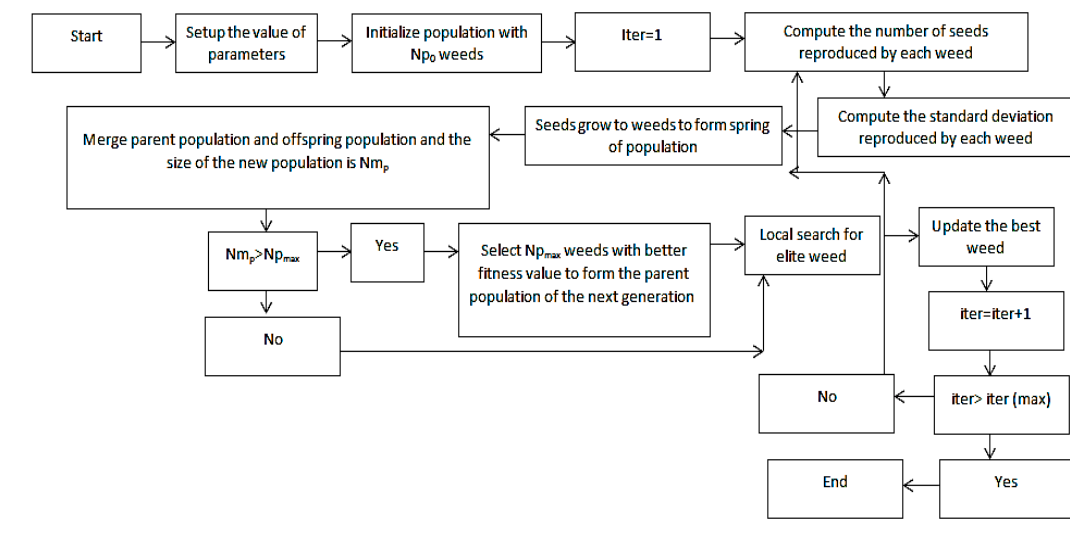
Figure 2. Improved weed algorithm (IWA) process.